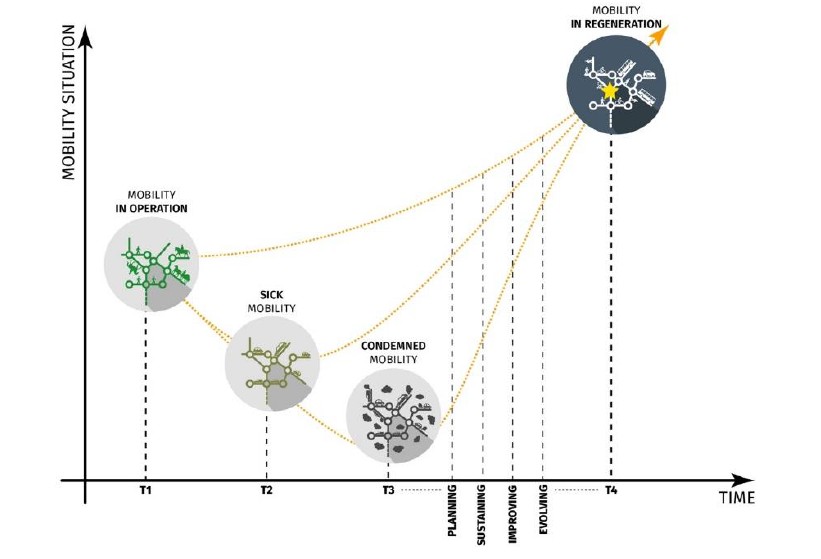
Figure 2. Regeneration process of "impaired mobility". Source: Authors.